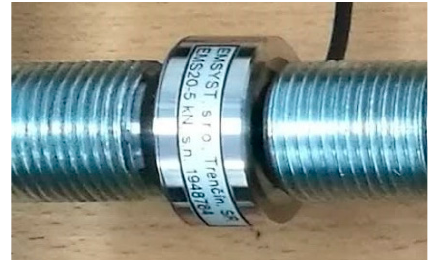
Figure 5. Tensometric force sensor EMS20.